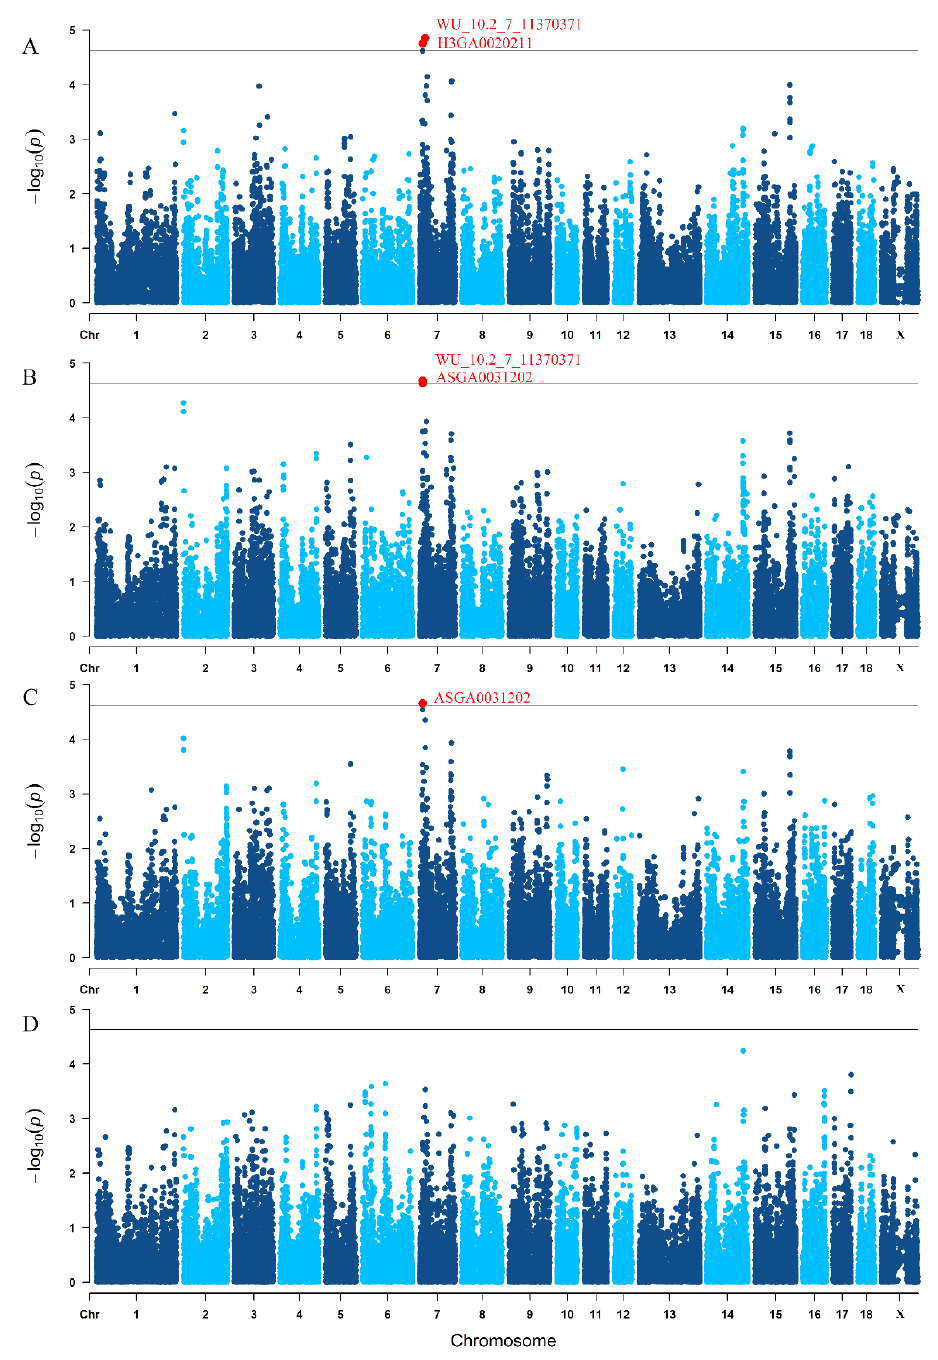
Figure 1. The Manhattan plots of genome-wide association study for four reproductive traits. ( A ) TNB: total number born; ( B ) NBA: number born alive; ( C ) NHP, number healthy piglets; ( D ) LWB: litter weight born alive. Each dot represents one SNP. The y-axis represents − log10(P). The x-axis represents the position of SNPs. The horizontal solid line depicts the chromosome-level significance threshold value.